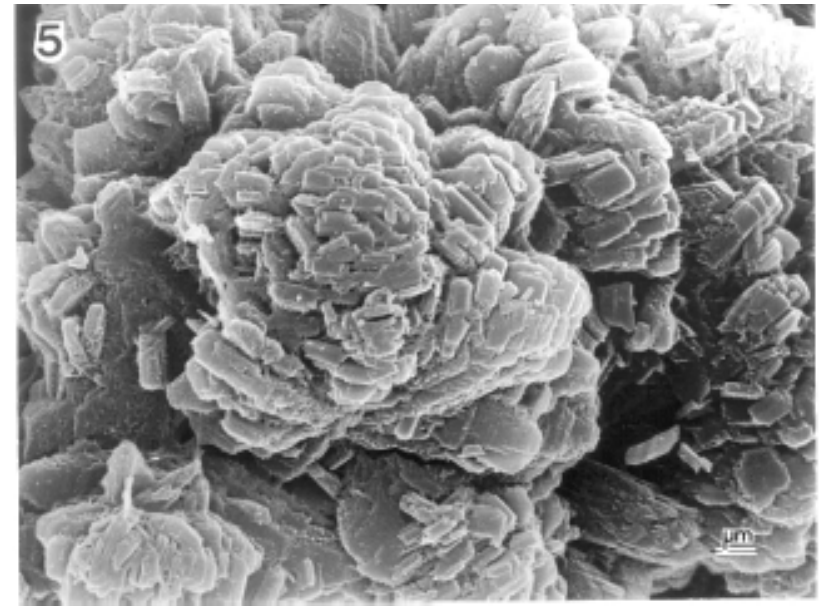
Fig. 5 – SEM of one particle of Figure 4 at higher